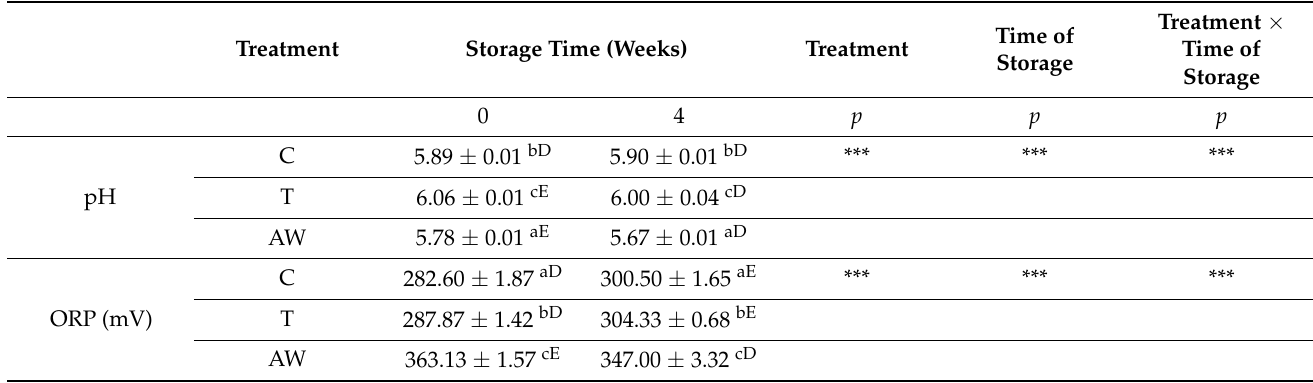
Table 3. Values of pH and potential redox (ORP) of fermented pork bacon (means ± standard deviations). Treatment Storage Time (Weeks) Treatment